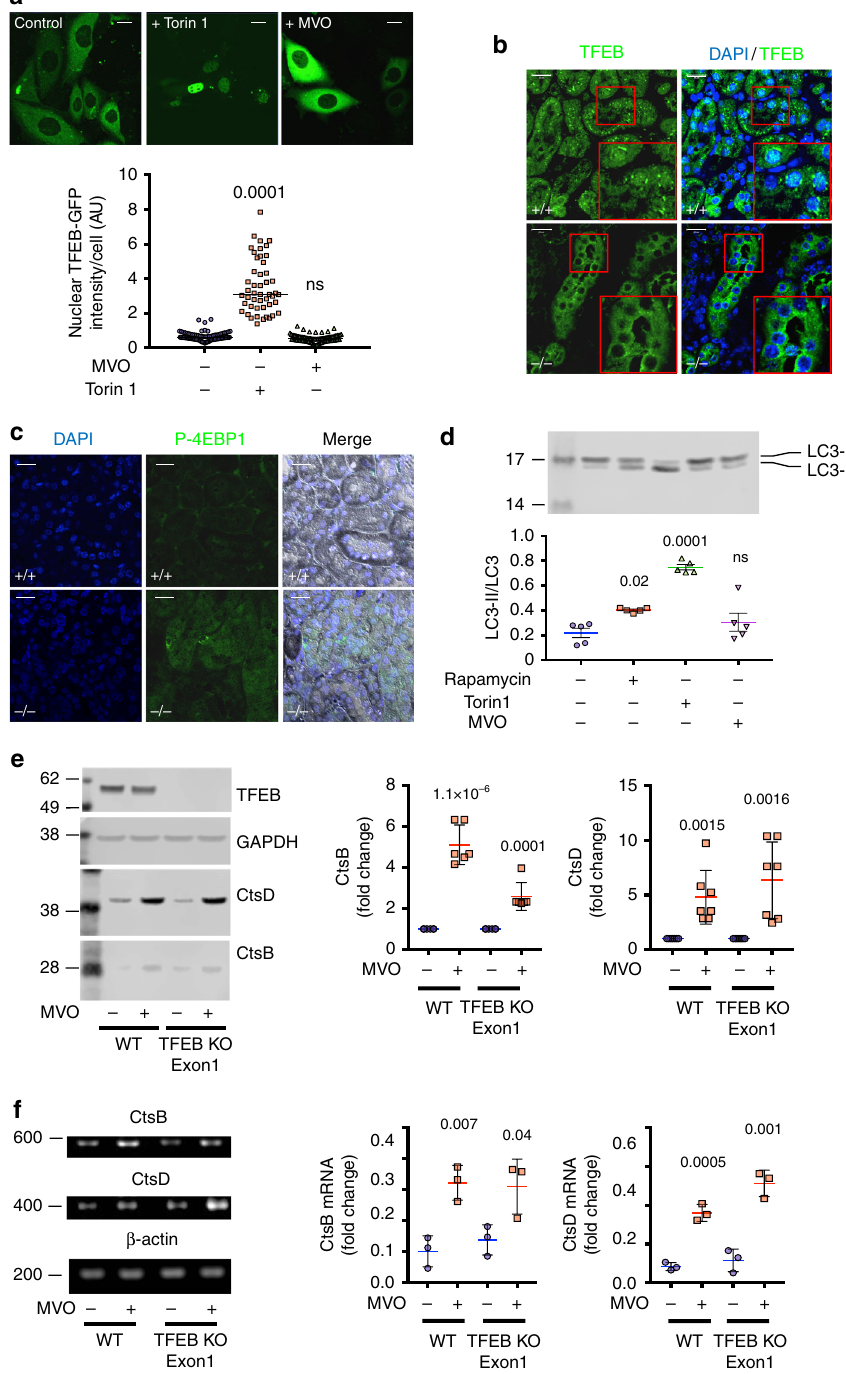
Fig. 4 Increased lysosomal hydrolytic capacity induced by chronic or acute AEP-de fi ciency does not depend on TFEB activation. a Cellular localisation of TFEB-GFP in HKC-8 cells treated or untreated with 50 μ M MVO26630 or 1 μ M Torin1 overnight. (Scale bar = 20 μ m). Data are the average ± SD of n = 93 cells for control sample, n = 48 for Torin1-treated sample and n = 92 for MVO-treated sample. Statistical signi fi cance was calculated using a Dunnett ’ s multiple comparison test. b Localisation of TFEB by IF in WT and AEP − / − kidney sections. (Scale bar = 20 μ m). c Levels of P-4EBP1 by IF in WT and AEP − / − kidney sections. (Scale bar = 20 μ m). d Immunoblotting and quantitation of LC3II/total LC3 ratio in lysates from WT MEFs treated with Rapamycin (1 μ M) or Torin1 (1 μ M) for 4 h or with MVO26630 (50 μ M) for 16 h. Data are the average ± SD of n = 5 biologically independent